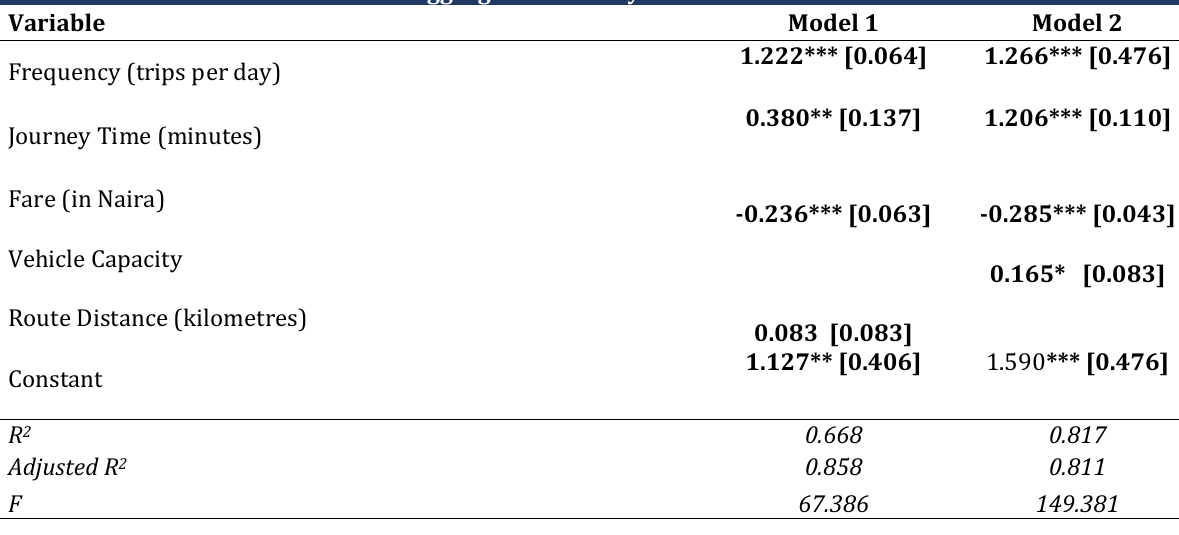
Table 2: Data Estimation Results for Aggregate Inter-city Travel Demand